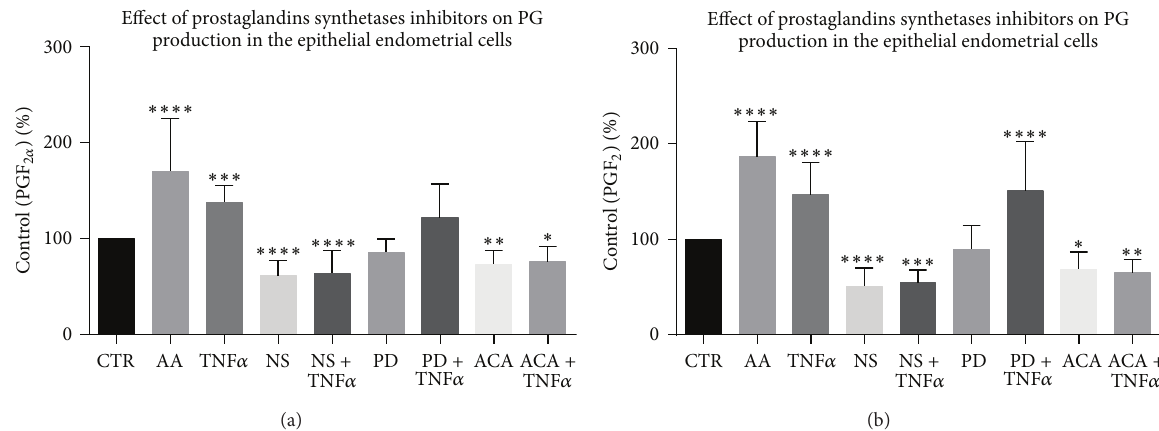
Figure 4: The content of PGF 2𝛼 or PGE 2 after different treatments as determined by immunoassays. Asterisks indicate statistical differences between prostaglandin levels depending on the treatment ( ∗ 𝑃 < 0.05 , ∗∗ 𝑃 < 0.01 , ∗∗∗ 𝑃 < 0.001 , and ∗∗∗∗ 𝑃 < 0.0001